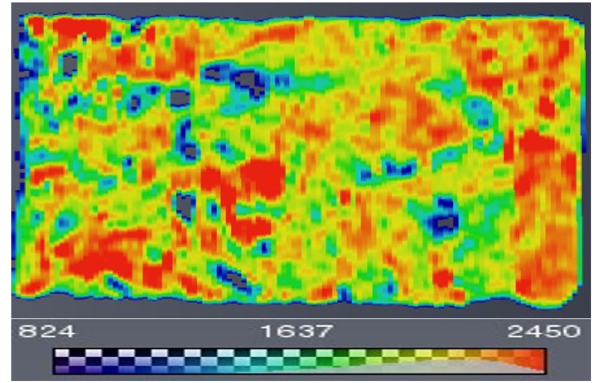
Table 5 Summary of major parameters from the second core